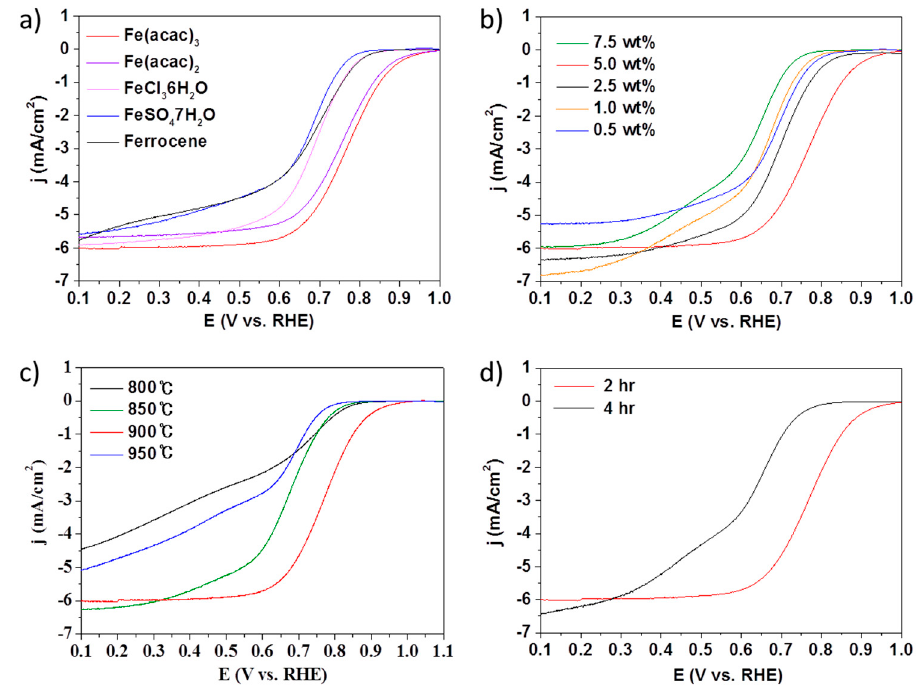
Figure 1. Linear sweep voltammetry curves of oxygen reduction reaction (ORR) in 0.1 M KOH catalyzed by Fe x N y /NC prepared by altering synthetic conditions. ( a ) Fe source, ( b ) Fe contents, ( c ) pyrolysis temperature, and ( d ) pyrolysis time.